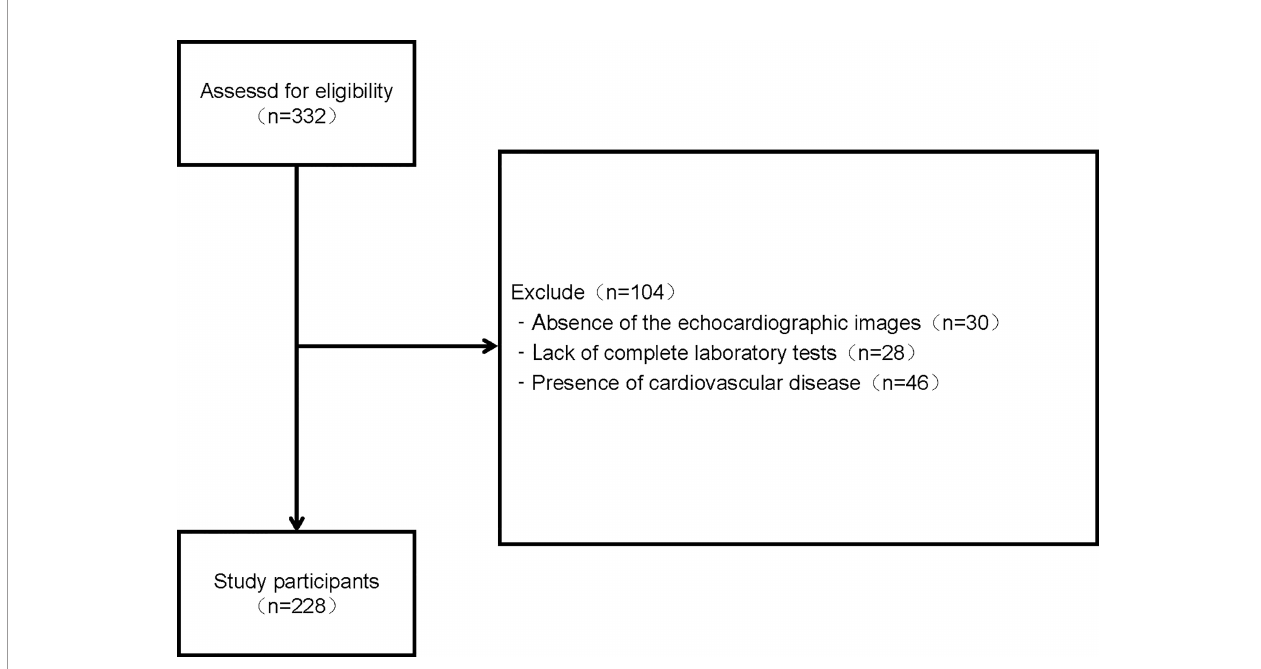
FIGURE 1 | Flowchart of enrolled study